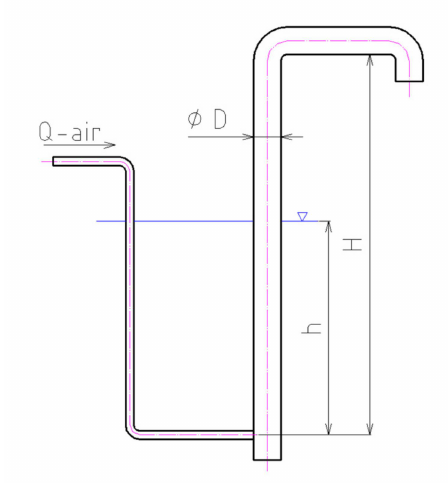
Figure 2. Sketch of an airlift pump with main